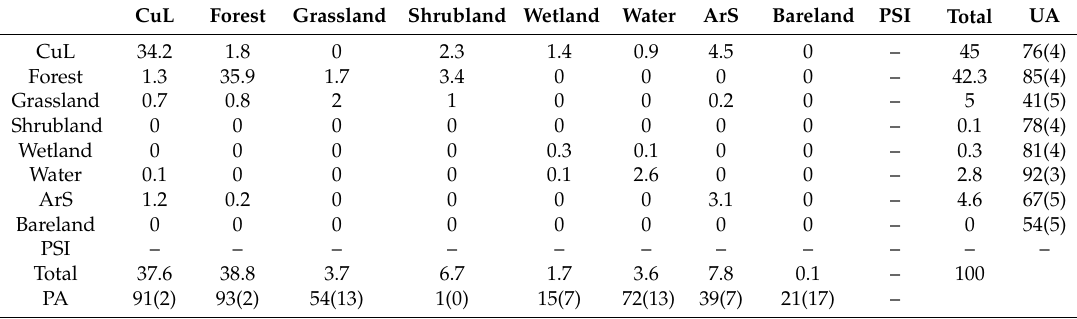
Table A7. The error matrix of estimated area proportions for R7: Overall accuracy is 78.1% (2.5%).